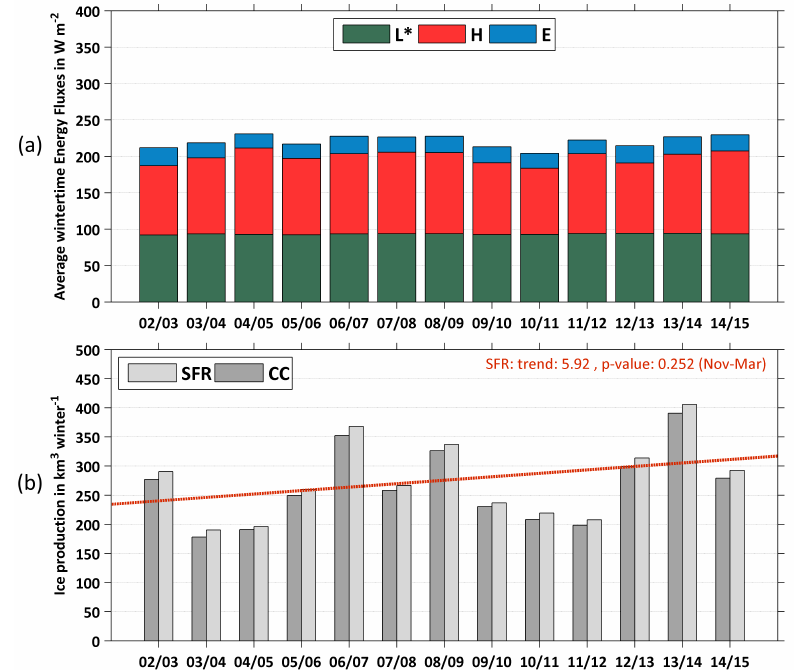
Figure 10. ( a ) Average wintertime (November to March) energy fluxes of net long-wave radiation (L*), sensible (H) and latent (E) heat (all in W ¨ m ´ 2 ) within the applied polynya mask. ( b ) Annual wintertime accumulated ice production (IP) in the NOW polynya (in km 3 ¨ winter ´ 1 ) for 2002/2003 to 2014/2015. Estimations of IP are based on heat flux calculations using the daily derived TIT composites. Special emphasis is given to the effect of an applied cloud-cover correction (CC/SFR). The red dotted line shows a linear trend estimation for IP SFR . Table 4. Accumulated ice production in km 3 per winter and average polynya area (in 10 3 km 2 ) for each winter season (November to March) from 2002/2003 to 2014/2015 in the North Water Polynya, together with the interannual average (mean) and its standard deviation (SD). Cloud-cover corrections have been applied where CC denotes the values after coverage correction and SFR denotes the values after the spatial feature reconstruction (see the text). All values are derived from daily MODIS TIT composites after application of the predefined polynya mask (Figure